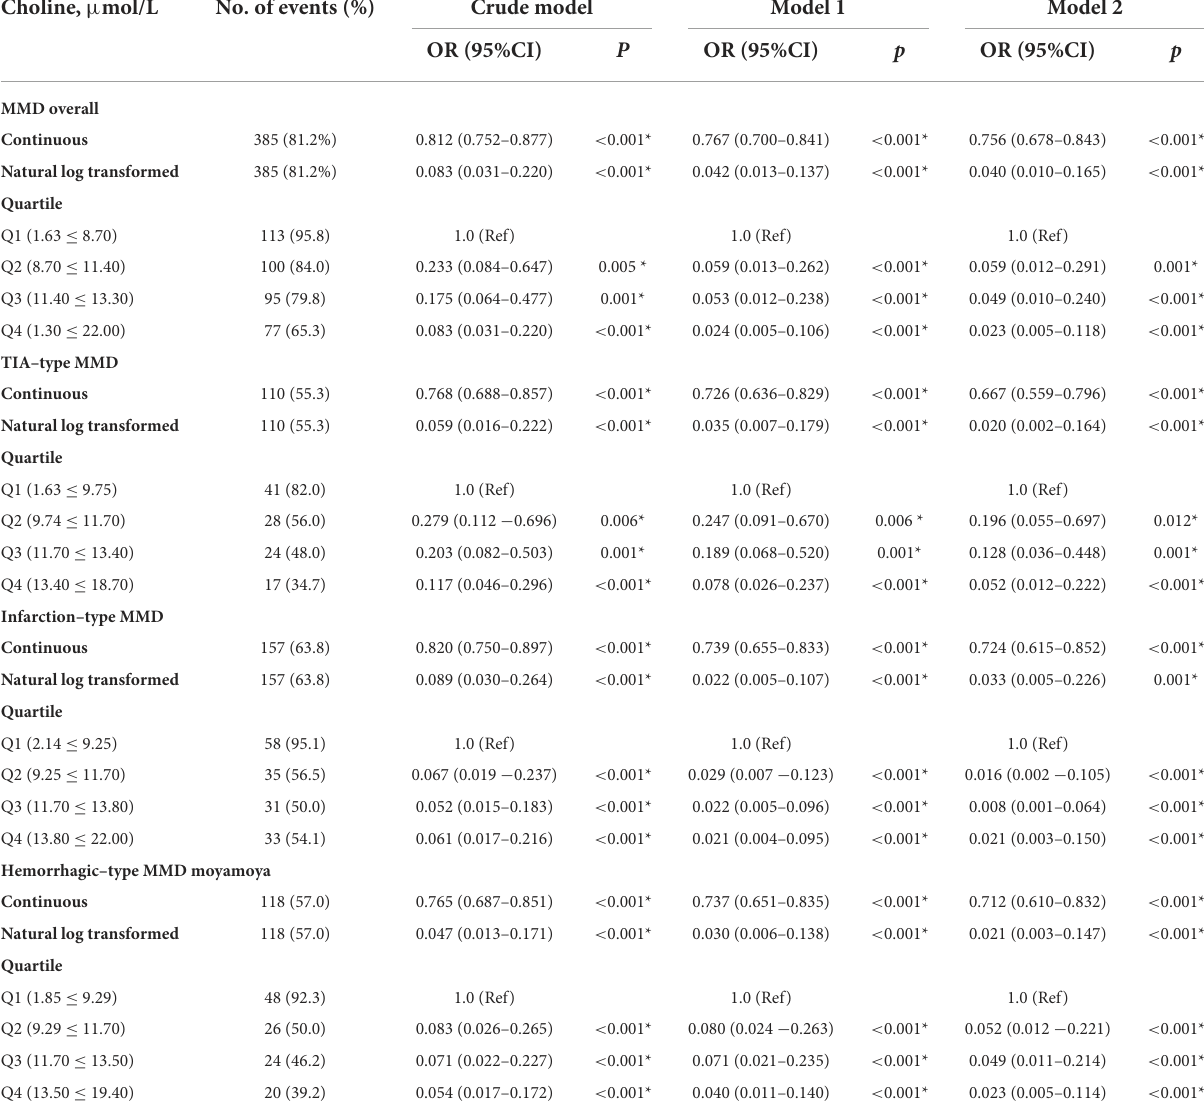
Crudemodel:unadjustedlogisticregressionmodel;Model1:adjustedforage,sex,heartrate,SBP,DBP,andBMI;Model2:furtheradjustedforWBCcount,lymphocytecount,neutrophil count,plateletcount,albumin,creatinineuricacid,triglyceride,totalcholesterol,HDLcholesterol,LDLcholesterol,ApoA,ApoB,homocysteine,andeGFR. *p <